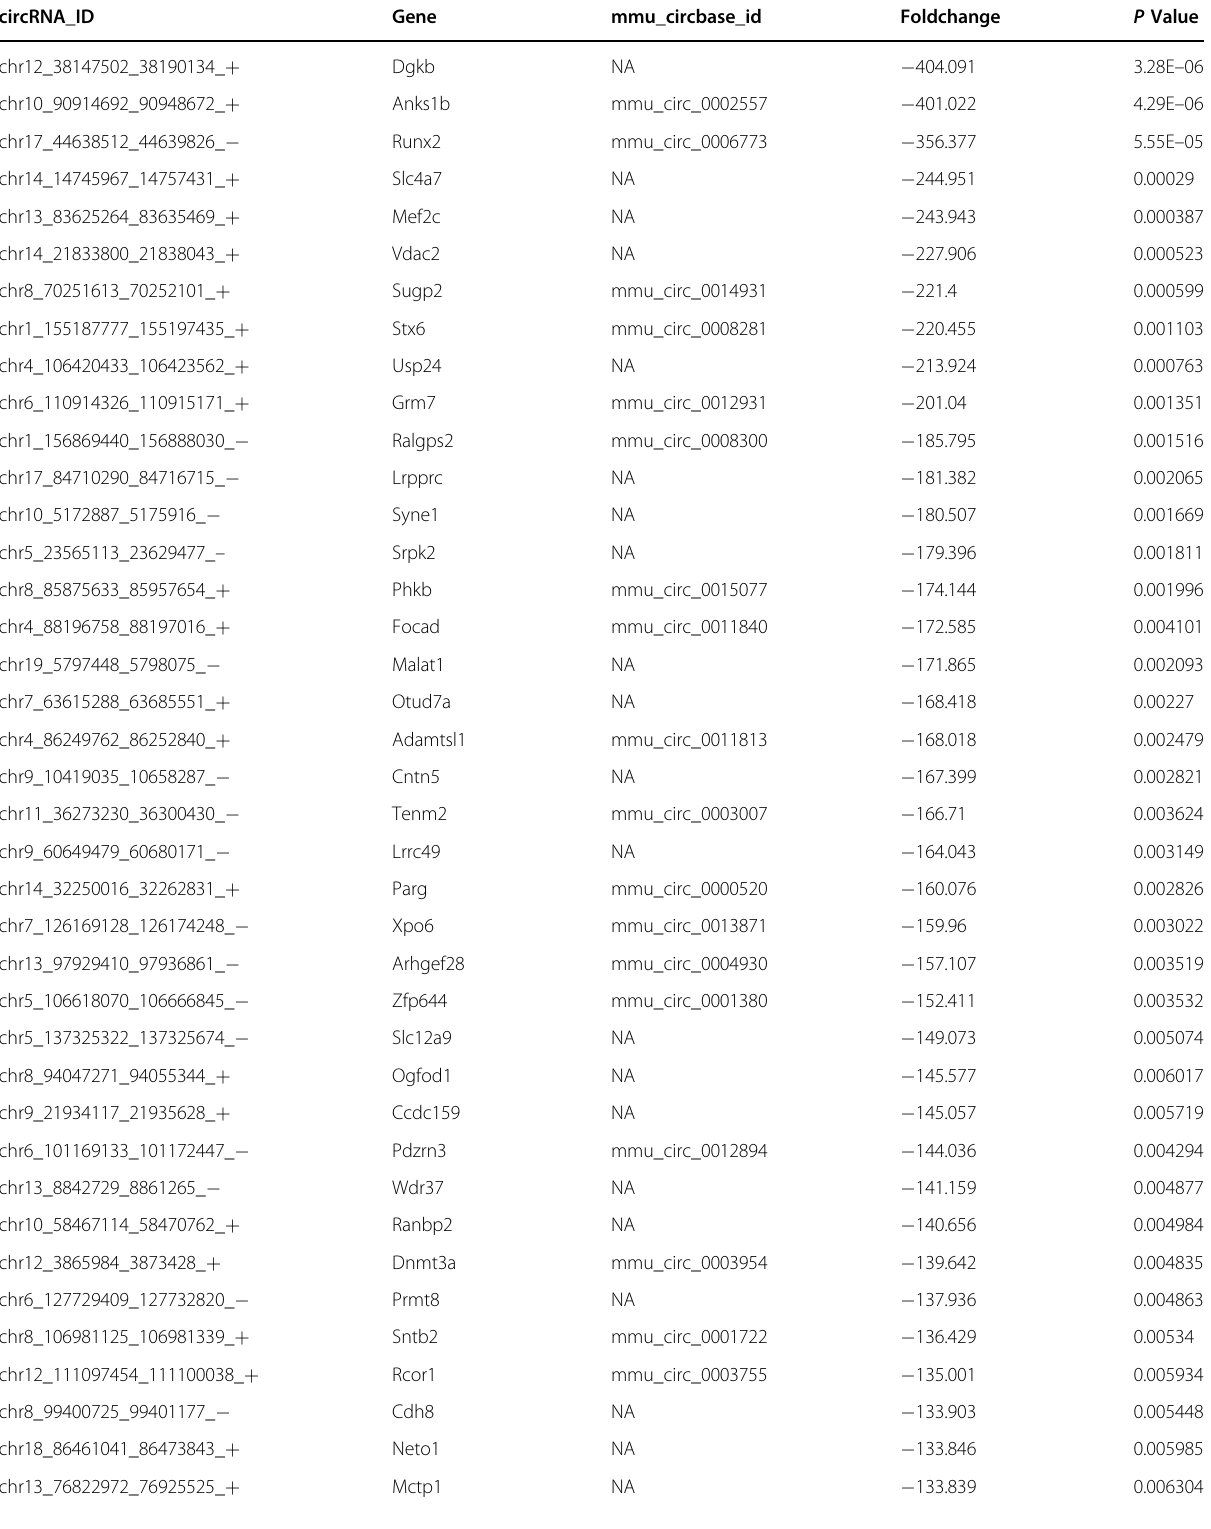
Table 1 Different expression of circRNAs in the brain of high sugar & fat diet induced dysbacteriosis mice (control vs model group, |Foldchange| >1.50, p <